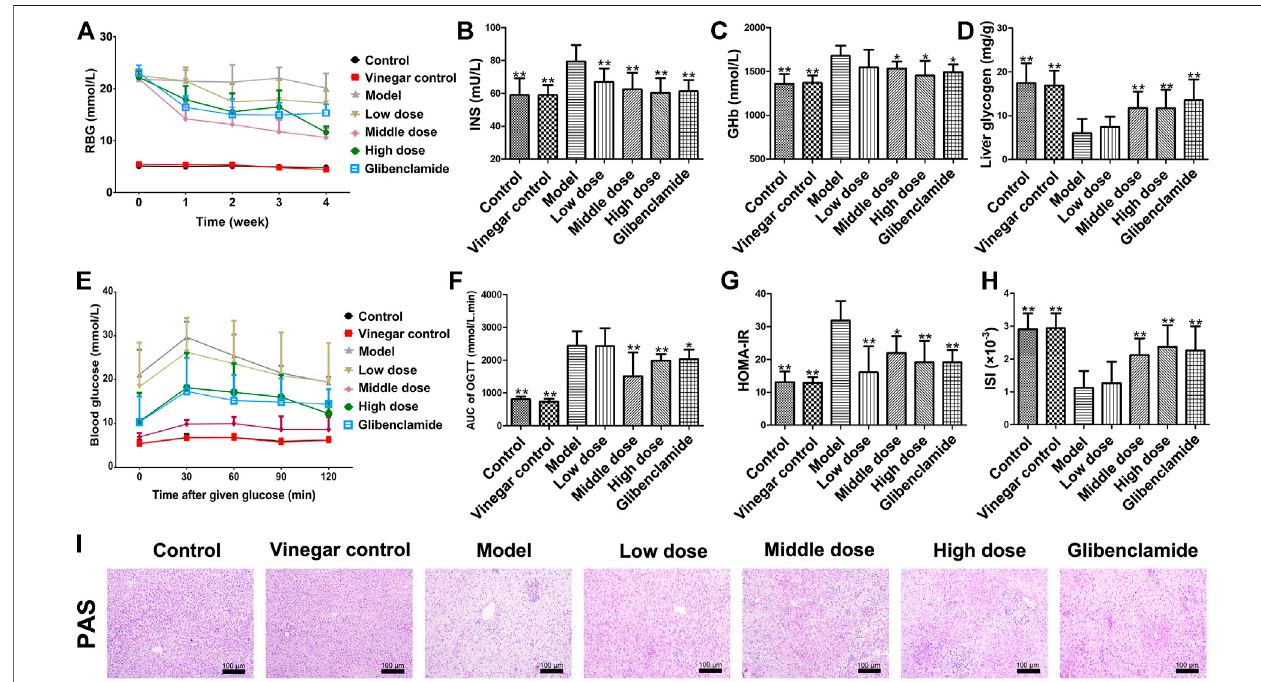
FIGURE 3 | Effect of HSAV on glycometabolism of T2DM rats. (A) Random blood glucose (RBG) (Weekly after administration); (B) insulin (INS) level in serum; (C) GHb level in serum; (D) liver glycogen content; (E) OGTT; (F) AUC of OGTT; (G) HOMA-IR; (H) ISI; (I) PAS staining of liver tissue. Data are presented as the mean ± SD (n (cid:2) 10). * p < 0.05 and ** p < 0.01 compared with model group.